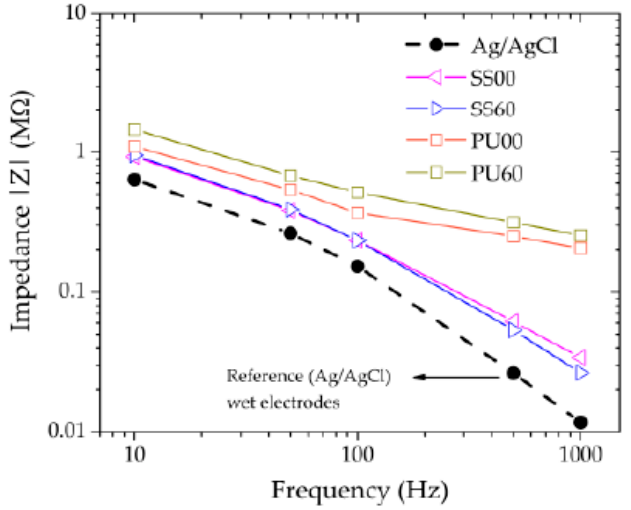
Figure 7. Grand average impedance values of the five measurement frequencies and the different electrodes calculated over all volunteers.